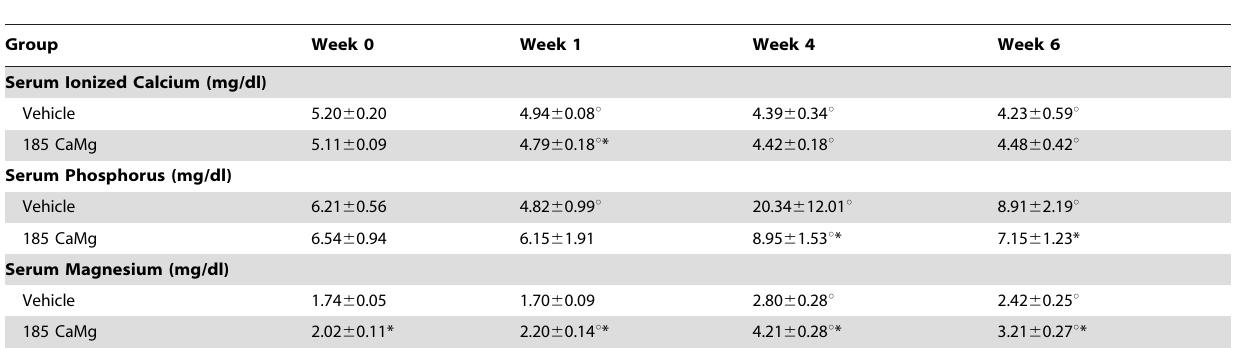
Table 1. Serum biochemistry of vehicle versus 185 mg/kg CaMg treated adenine-induced CRF rats.